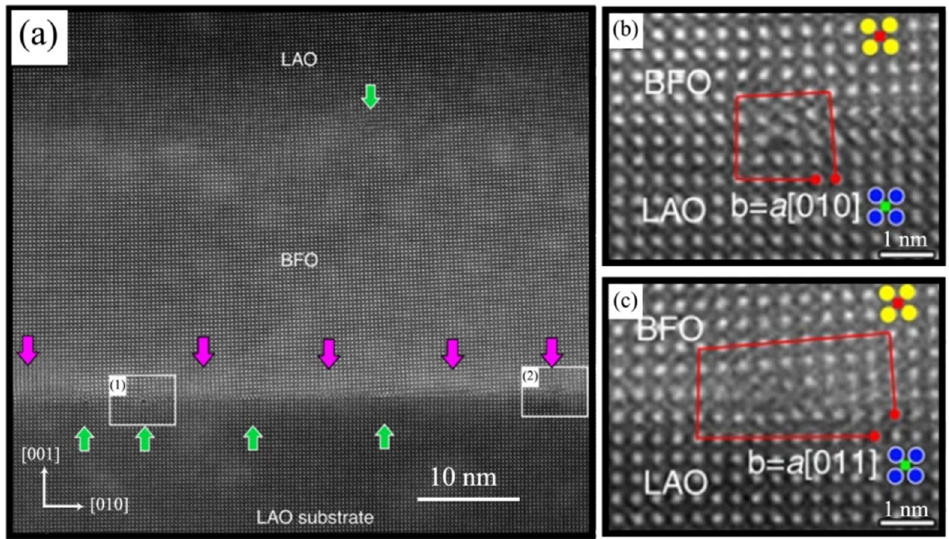
Figure 5. Misfit dislocations on the BiFeO 3 /LaAlO 3 interface. Reprinted with permission from [100] 2017 Springer Nature. ( a ) HAADF-STEM image of the interface. Pink and green arrows indicate two different types of misfit dislocations magnified in ( b ) and ( c ), respectively. ( b ) Magnification of region 1 in ( a ), which shows a misfit dislocation with Burger vector b = a [ 010 ] . ( c ) Magnification of region 2 in ( a ), which shows a misfit dislocation with Burger vector b = a [ 011 ]